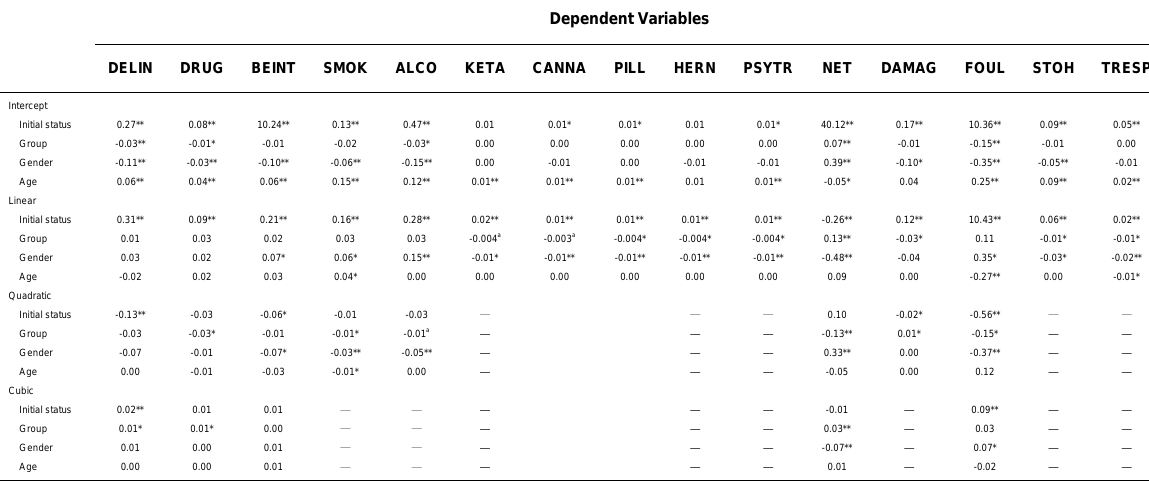
Growth Curve Models for Problem Behavior Indicators with Subjects who Joined the Tier 1 Program and Perceive the Program as Effective being Experimental Subjects